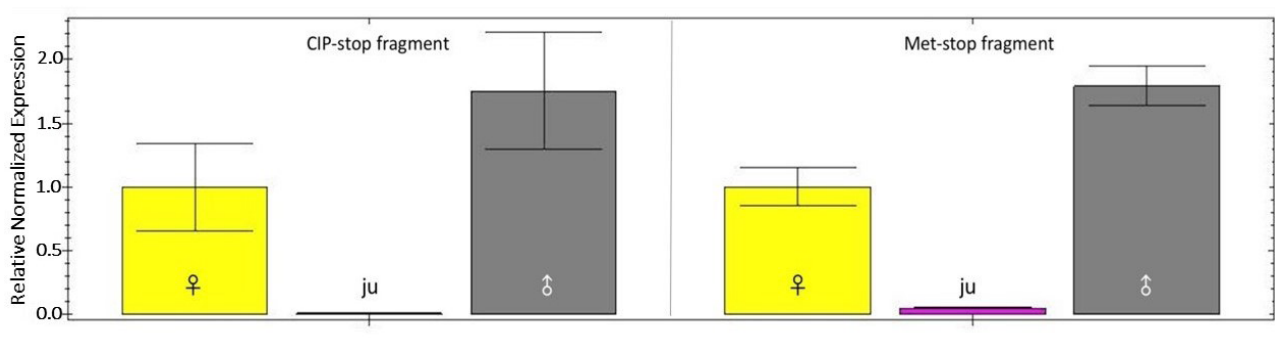
Figure 8. Expression of the PpenTox1 gene in a population of male, female, or juvenile Phonotimpus pennimani spiders, normalized with the reference genes EloFa and SD. CIP-stop fragment: expression of the truncated region of PpenTox1 (CIP-stop, 201 bp); Met-stop fragment: expression of the complete PpenTox1 transcript (Met-stop, 381 bp); ju: expression in a population of juveniles; ♂: expression in a population of males; ♀: expression in a population of females. The relative quantification (normalized to the reference genes) shows the standard deviation from a number of repetitions per